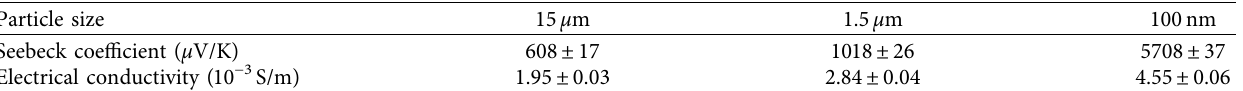
2 O powders with different particle sizes.